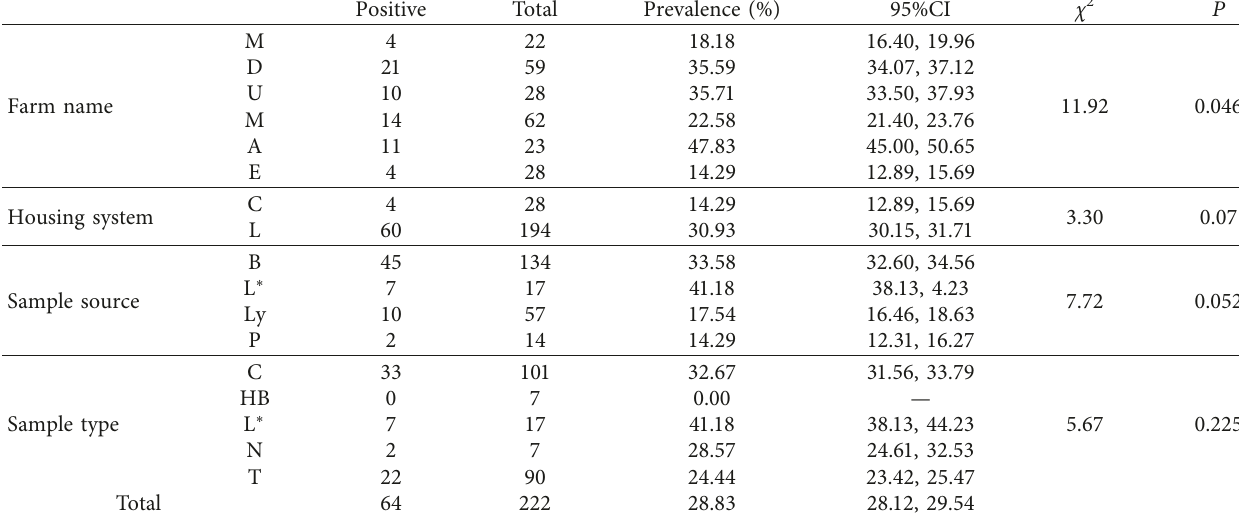
Table 1: Distribution of Staphylococcus isolates in different farms, housing systems, sample source, and sample types.